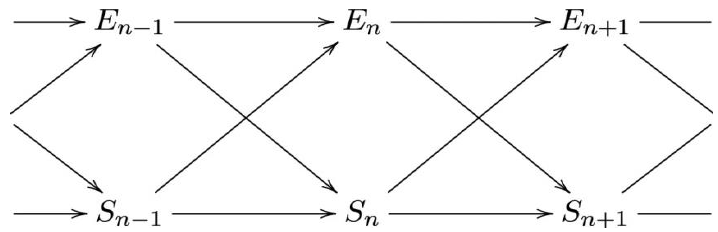
Figure 1. The causal diagram of the system – environment interaction [4].